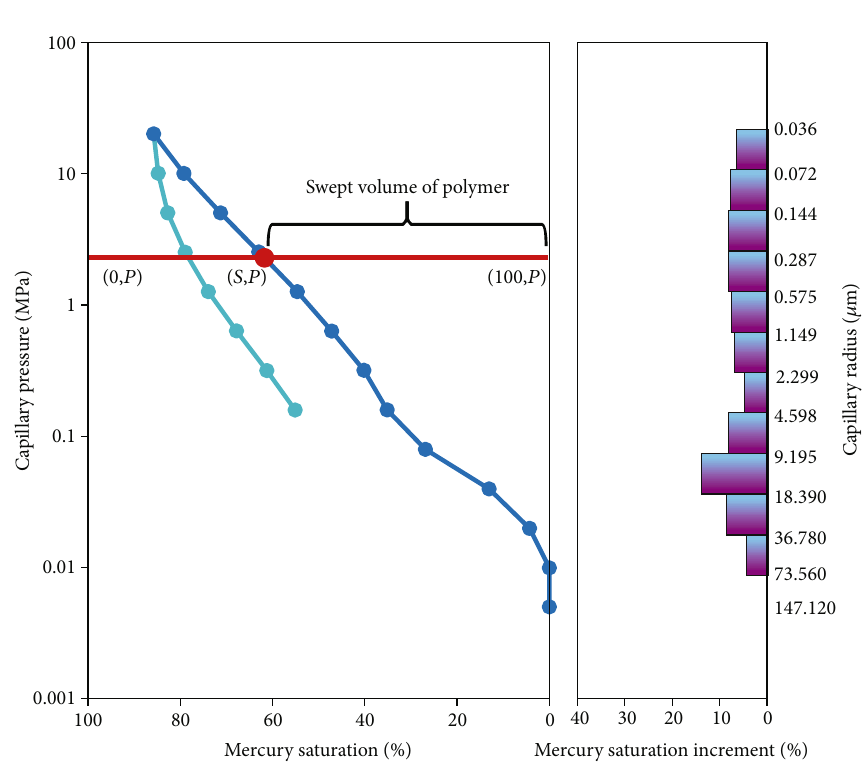
Figure 1: Schematic diagram of pore volume a ff ected by polymer solution.